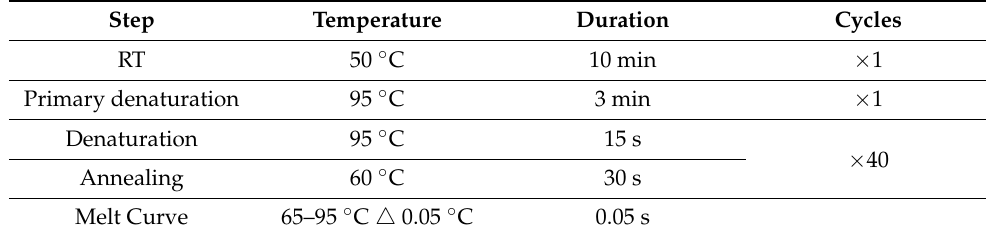
Table 2. Real-time polymerase chain reaction